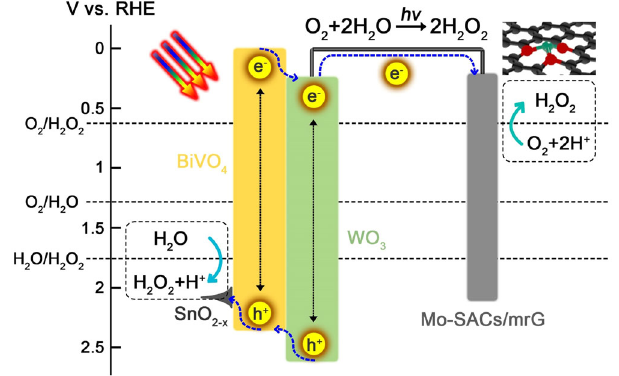
Fig. 2 | Energy-level diagram of the photoanode and cathode: type 2 hetero- structures formed between BiVO 4 /WO 3 . Photo-induced electron-hole pairs were separated viatheinnerelectronic fi eld;theelectrontransferred tothe single-metal sites in the cathode through the external circuit to complete the 2e − ORR reaction, while the hole transferred to the BiVO 4 surface and participated in the 2e − WOR on the SnO 2-x /BiVO 4 /WO 3